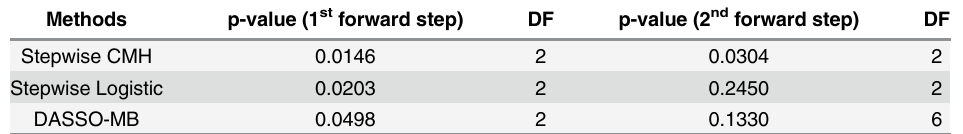
Table 3. Toy example dataset application